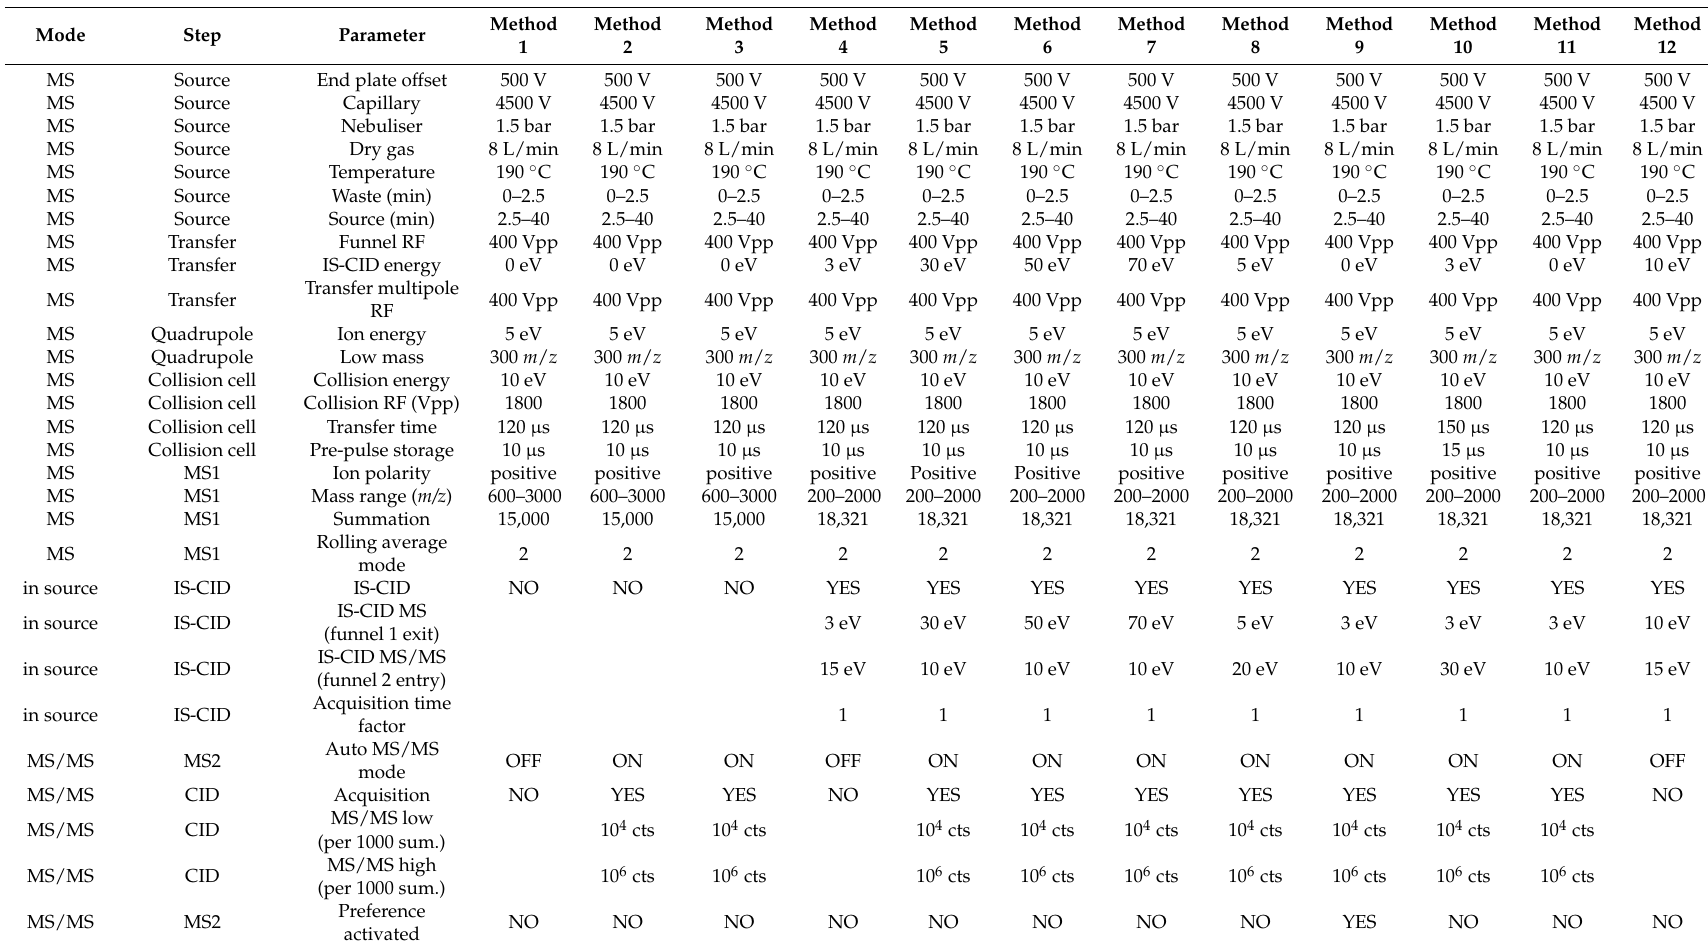
Table 1. Parameters applied on the Q-TOF mass spectrometer for the 12 MS